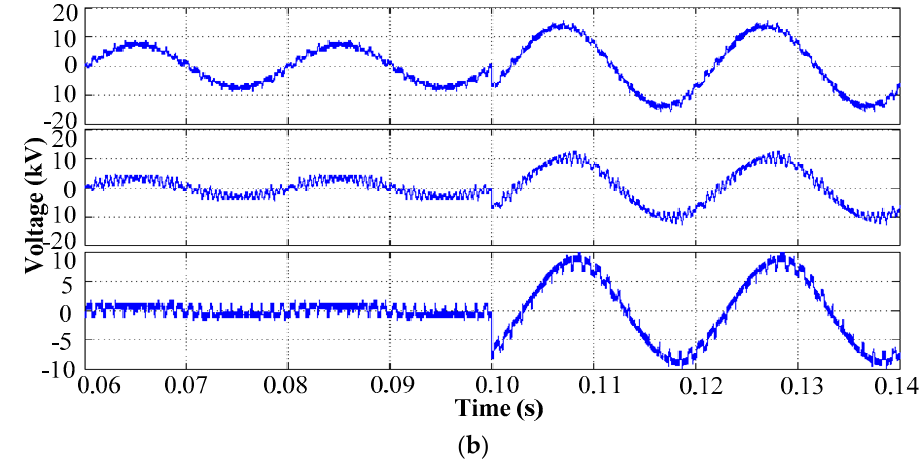
Figure 10. Simulation results: Related voltages under normal and fault conditions. ( a ) The CMV at a neutral point; ( b ) the voltage potential between the midpoints of the HVPCs and ground (From top to bottom: v 6 , v 3 , and v 1 Aog Aog Aog